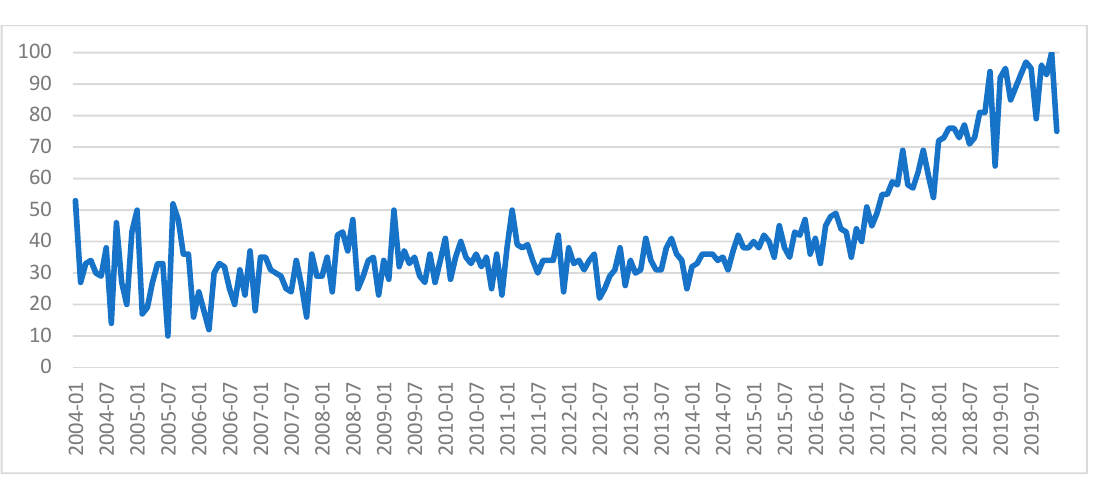
Figure 3. Google Trends for the search term “Agile Management” (worldwide) (data source: www.trends.google.com, retrieved 5 December 2019).